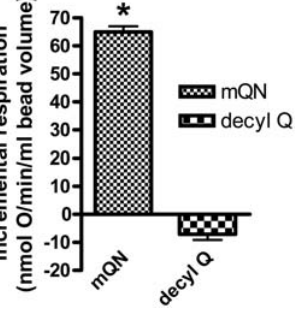
Figure 6. Oxygen consumption by cells perfused on glass beads exposed to mitoquinone (1 m M) or the control com- pound decylQ (1 m M). Values (mean 6 SE) represent incremental changes in oxygen consumption (compared to perfusate alone) after addition of mitoquinone or decylQ to the perfusion medium. * p , 0.001 compared to control (n=3). and Dikalov [21] who recently used inhibitor analysis to propose a model wherein mitoQ undergoes highly efficient redox cycling at two sites within complex I, one proximal and one distal to the putative rotenone binding site, where rotenone is believed to block electron transfer from the N2 iron-sulfur cluster to ubiquinone